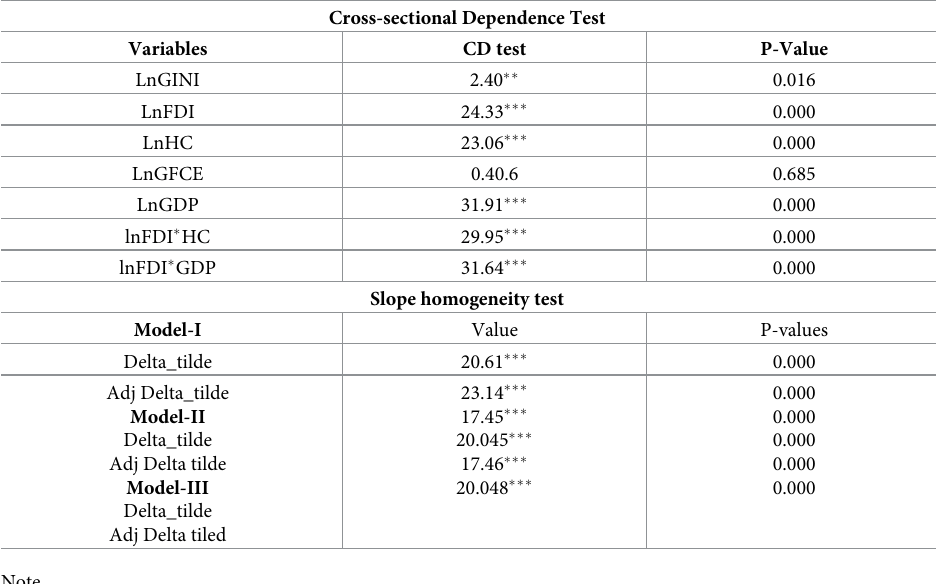
Table 2. Cross-sectional dependence and slope homogeneity tests.